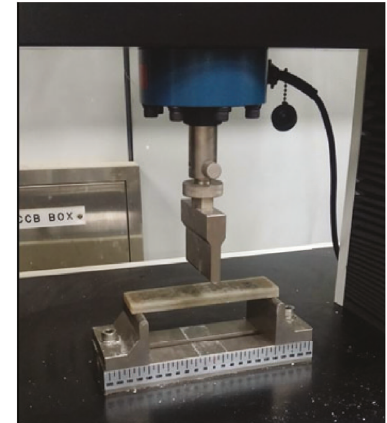
Figure 6: Flexural test setup.